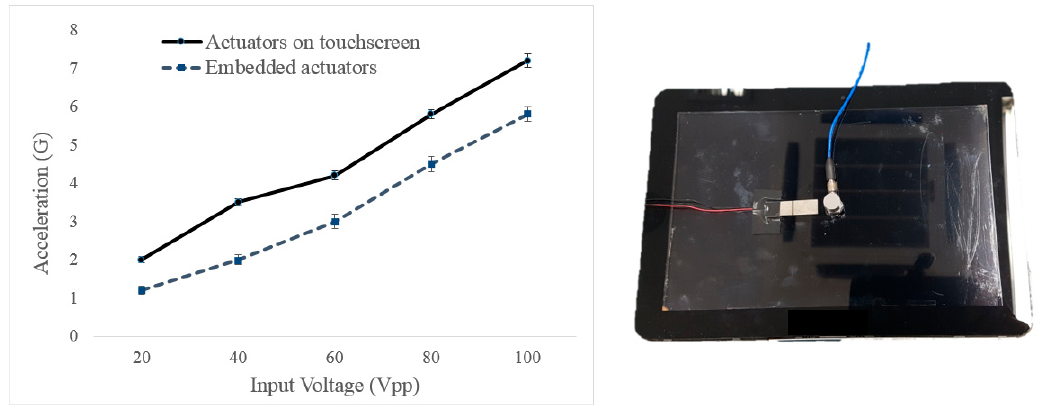
Figure 8. Acceleration values (left) measured on a 10.1 inch touchscreen with a three-layer piezoelectric actuator as a function of input voltage (Vpp) for two conditions, free stroke on a detached touchscreen (right) and after embedding the actuators in a tablet.